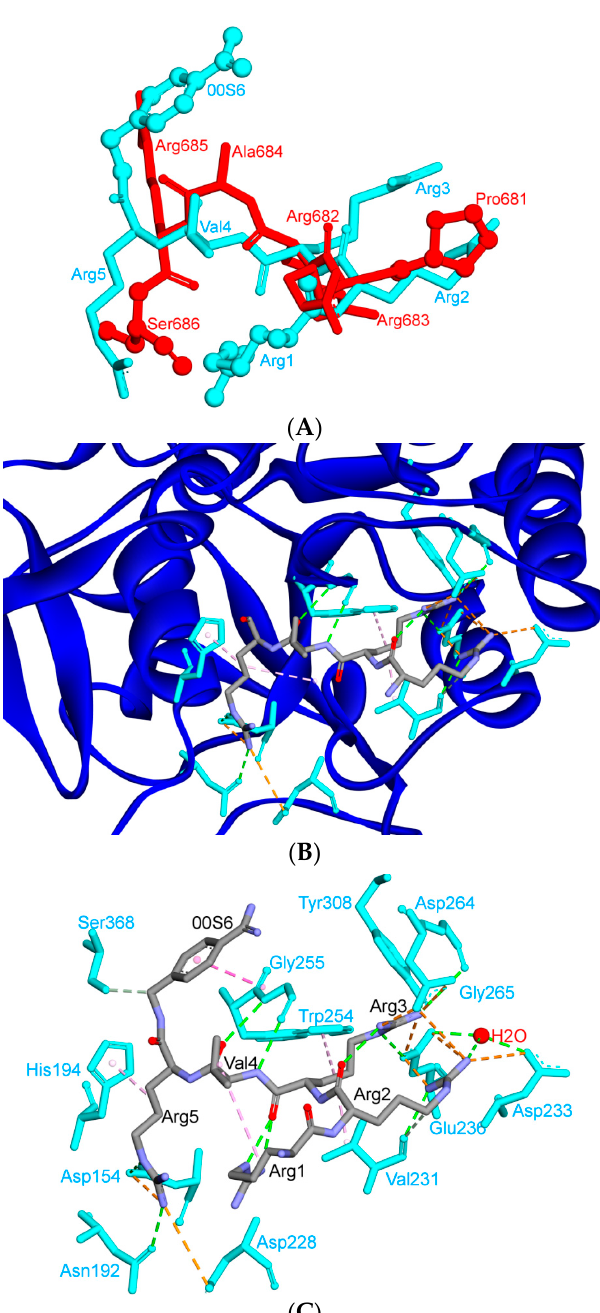
Figure 10. S1 / S2-1 furin cleavage site and its similarity to the I1 inhibitory peptide. ( A ) The alignment of the SARS-CoV-2 S1 / S2-1 site in SARS-CoV-2 with the I1 peptide. ( B ) The binding mode of the furin active site with the I1 inhibitory peptide. ( C ) The interactions of the I1 inhibitory peptide with the amino acids of the furin active site; same interactions are expected with the S1 / S2-1 cleavage site. Three-dimensional models were created using Discovery Studio (version 2.5.5, Biovia, San Diego, CA,